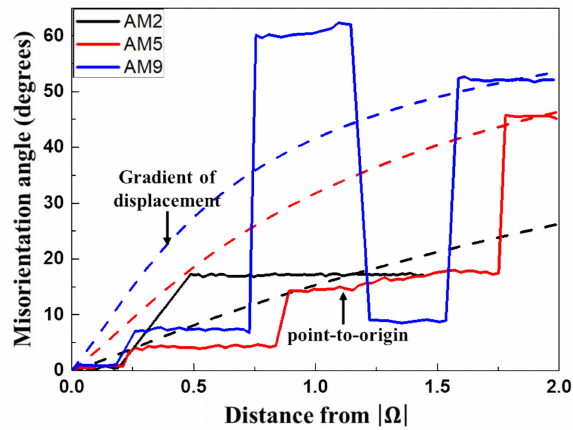
Figure 19. Misorientation angles profile across the rotated zone formed around the α -Al(Mn, Fe)Si precipitate measured by the prediction of displacement gradient and EBSD